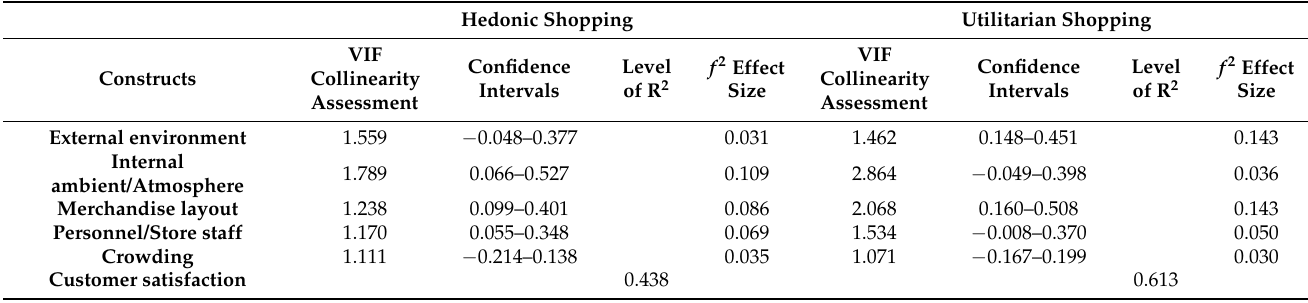
Table 5. Structural model